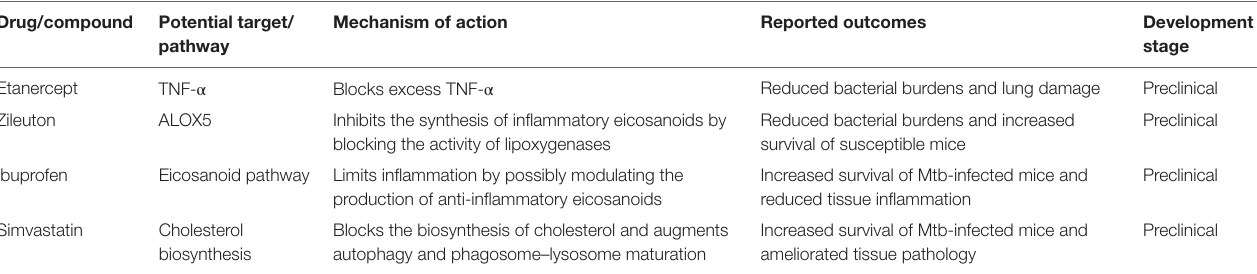
TABLe 1 | List of drugs inhibiting the inflammatory pathways implicated in granuloma dissociation with proven efficacy in animal models [adapted from Ref. (2, 6)].